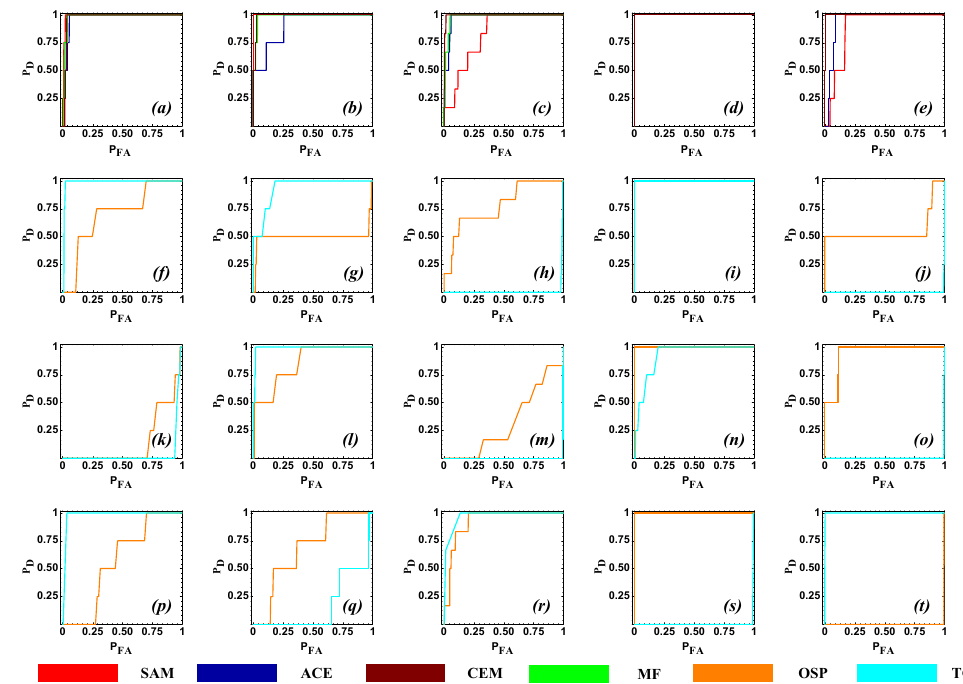
Figure 15. Target detection performance comparison in space-borne imagery for the airborne target reference spectra. ROC curves for the detection from SAM, ACE, CEM, and MF for the ( a ) N1G, ( b ) N2R, ( c ) N3Y, ( d ) C1W, and ( e ) N4B targets. ROC curves for the subspace-based detector OSP and TCIMF for the N1G, N2R, N3Y, C1W, and N4B targets for ( f – j ) 5, ( k – o ) 10, and ( p – t ) 15 endmember/background materials.